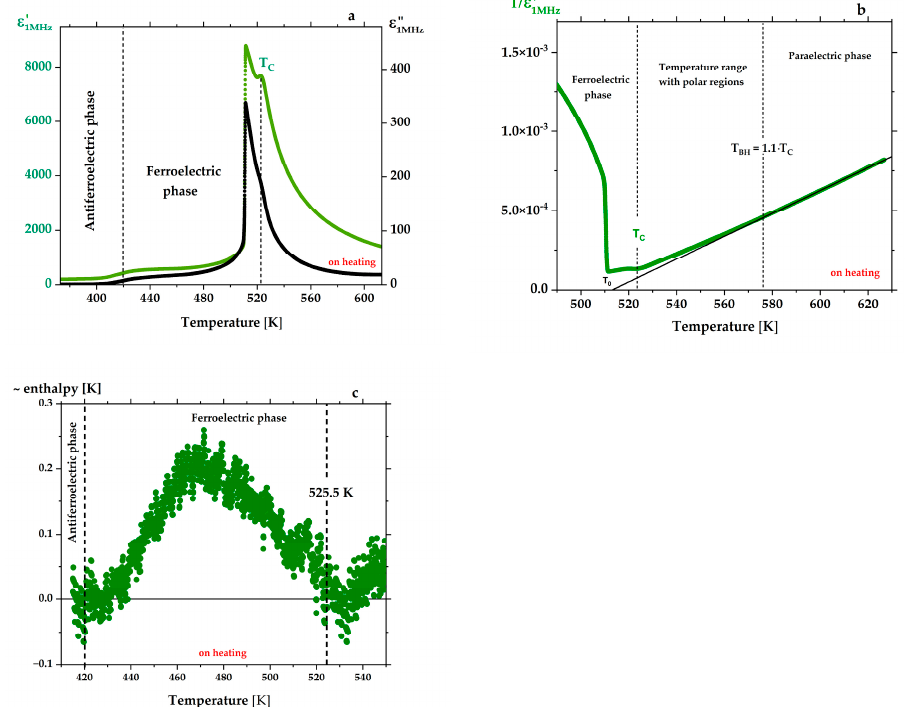
Figure 2. ( a ) Temperature dependence of the real ε ′ (in green) and imaginary ε ′′ (in black) part of the permittivity for PbZr 0.95 ± 0.01 Ti 0.05 ∓ 0.01 O 3 crystal. ( b ) As in Figure 1d, the 1/ ε ′ (T) function obeys the Curie–Weiss law only above the temperature T BH , which limits polar regions existing above T C and below T BH . ( c ) During the discontinuous phase transition, a change in the enthalpy takes place, and its changes can be recorded through the temperature changes (measured by the thermocouple placed close to the crystal) of 0.2 K/min with simultaneous measurement of ε (cid:48) (T). These enthalpy changes start near the AFE-FE transition and disappear around 525 K, i.e., close to the smaller maximum seen in ε (cid:48) (T) run in ( a ), and justify the placement of T C at this